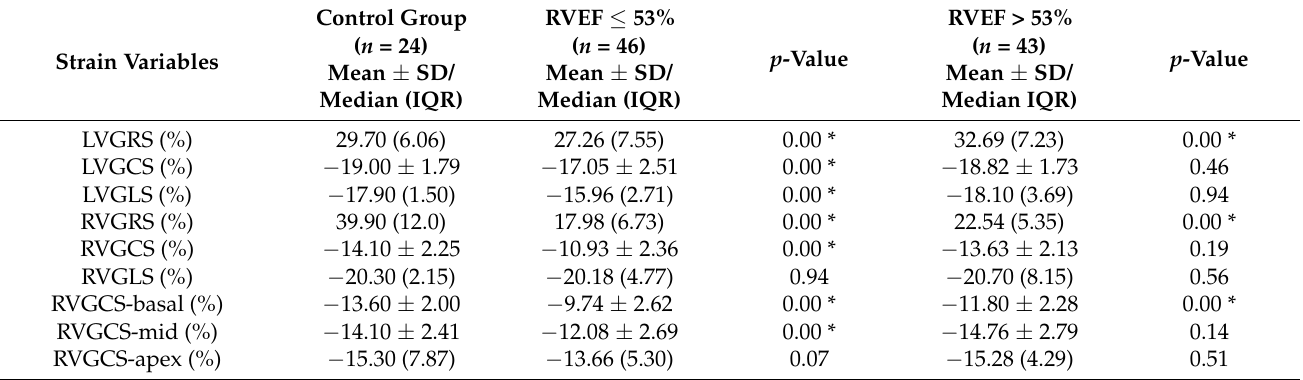
Table 6. Comparison of RV and LV strain values in normal and abnormal groups based on RV EF with the control